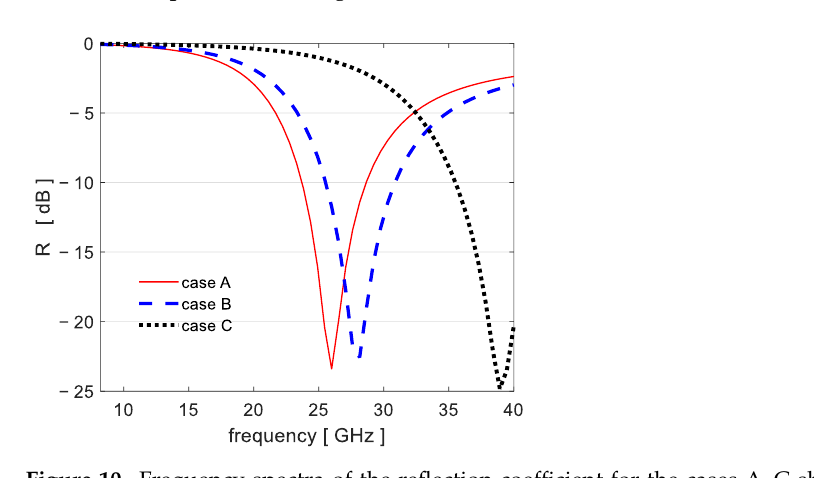
( b ) Figure 11. Reflection coefficients ( a ) R TM and ( b ) R TE as functions of the incidence angle for the cases A,B and C shown in Table 2 and composite filled with 2% of GNPs.